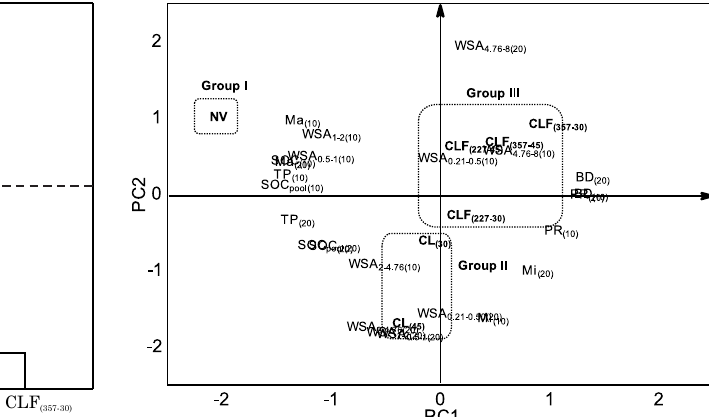
Figure 2. Dendogram of warm method showing similarities in soil physical attributes, SOC and SOC pool in all treatments.